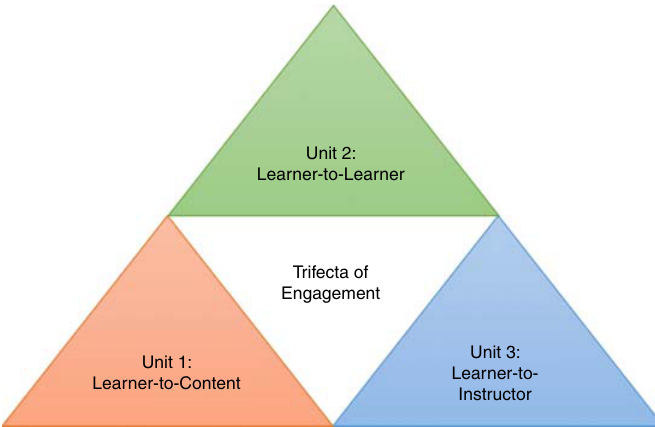
Figure 1. The trifecta